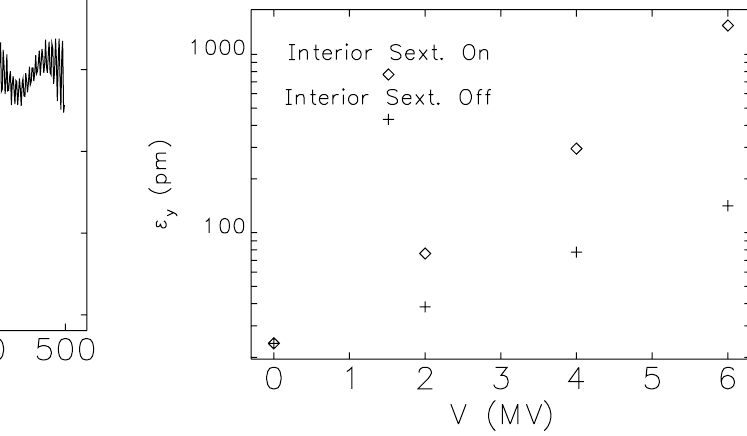
FIG. 9. Eventual vertical emittance as a function of deflecting voltage for h (cid:3) 8 , with interior sextupoles on and off, without synchrotron radiation